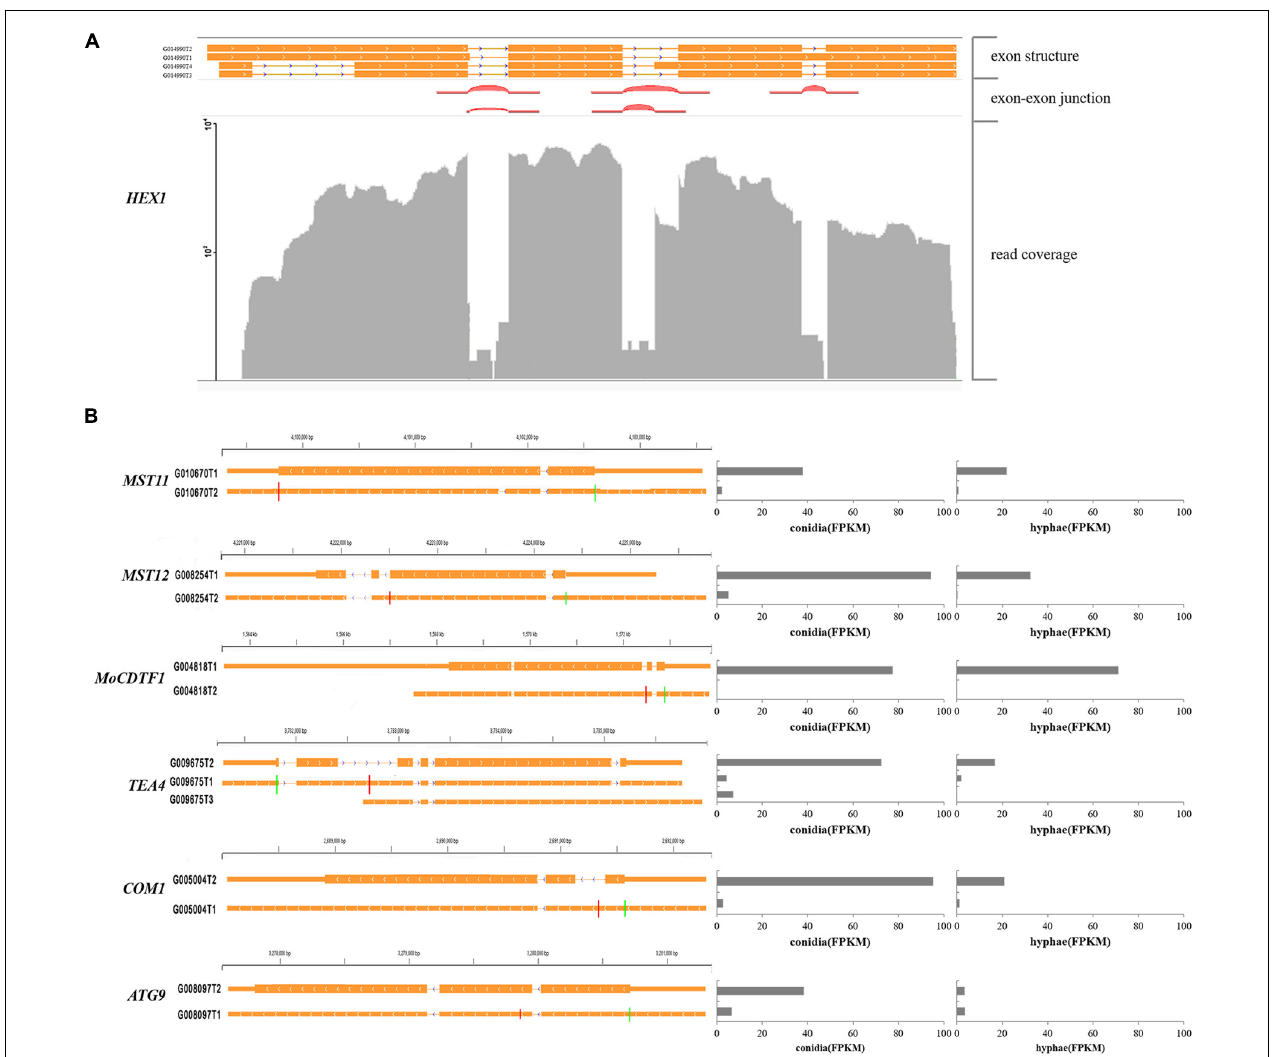
FIGURE 7 | Examples of pathogenicity-related genes with multiple transcripts. (A) Alternative transcripts of HEX1 . Exon-exon junctions were determined by Tophat. (B) Alternative transcripts (left) and their expression levels (right) of the marked pathogenicity-related genes. For each gene, a line meant a transcript of the gene. Exons are illustrated as orange lines, and the thick regions in exons indicate the coding regions. The green and red vertical lines represent translation start and stop sites, respectively. Chromosome coordinates are shown above each